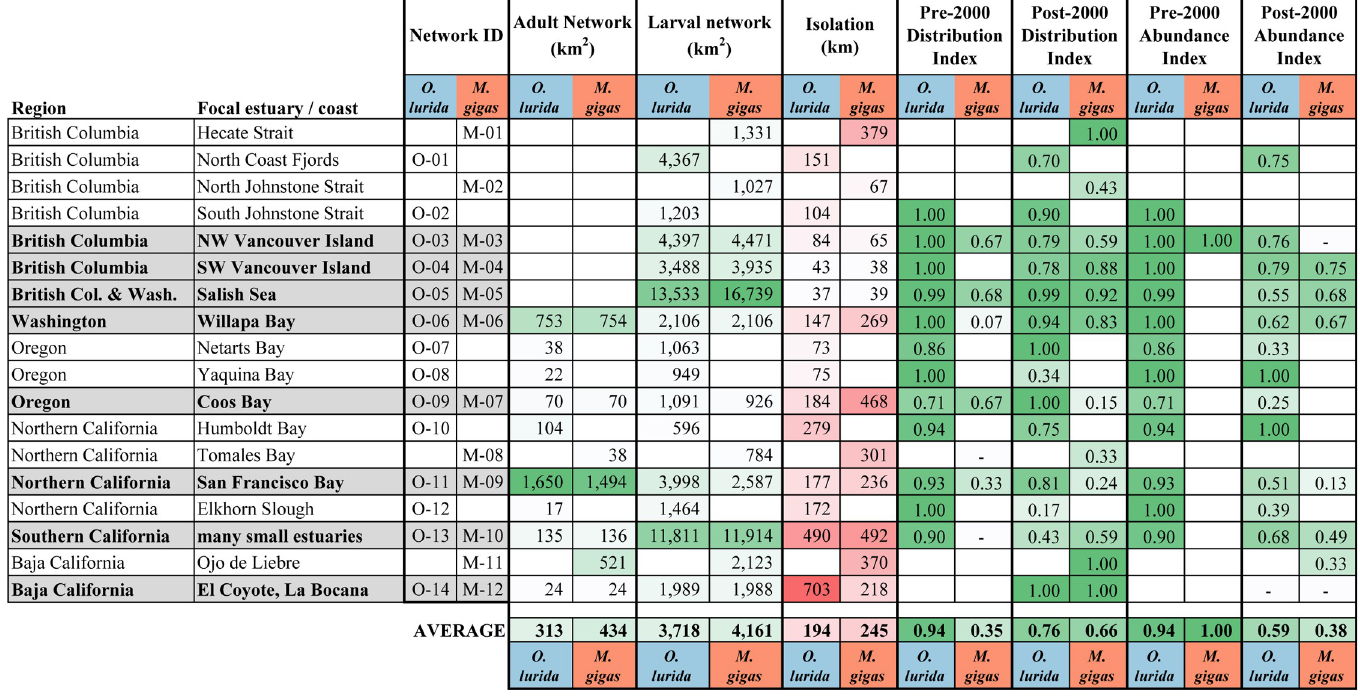
PLOS ONE | https://doi.org/10.1371/journal.pone.0263998 March 17,